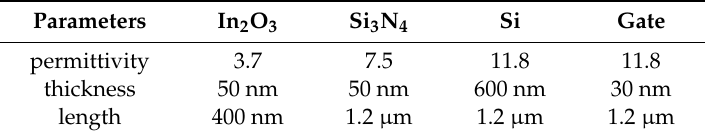
Figure 1. In 2 O 3 nanobelt field-effect transistor (FET): ( a ) FET cross-section of In 2 O 3 nanobelt and ( b ) FET 3D model of In 2 O 3 nanobelt. Table 1. Parameters in the simulation.